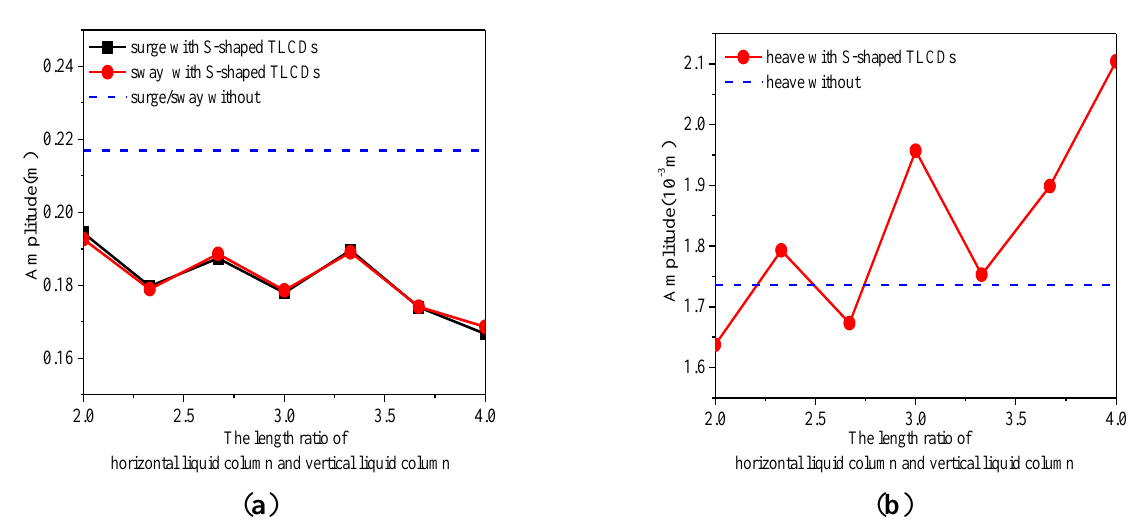
Figure 9. Comparison of responses for x 1 for, ( a ) heave; ( b ) roll, pitch.